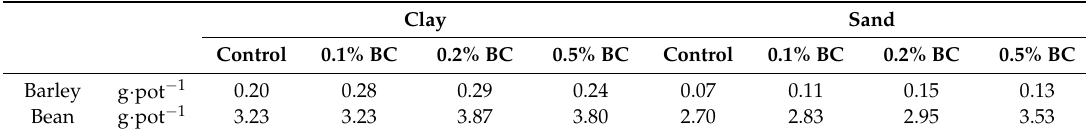
Table A2. Mean dry matter yield (DMY) of barley and bean treated with increasing biochar (BC) concentrations ( n =